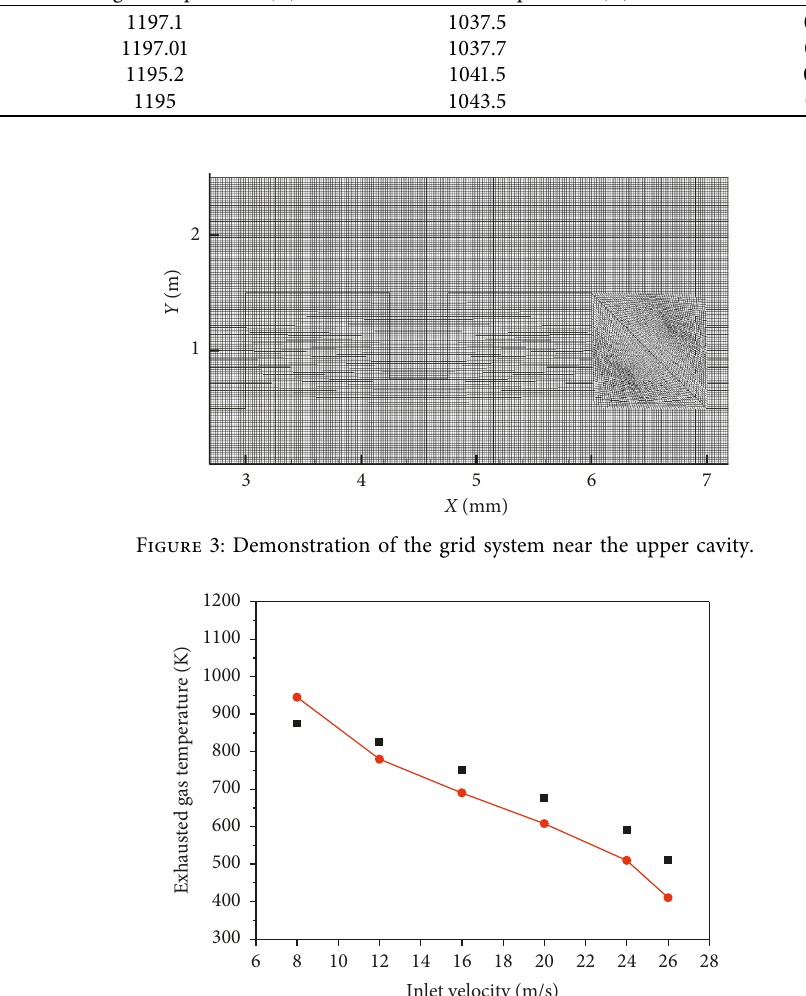
Table 2: Calculation results of the different grid spacings in the two-dimensional structure of a microcombustor. Grid spacing (m)